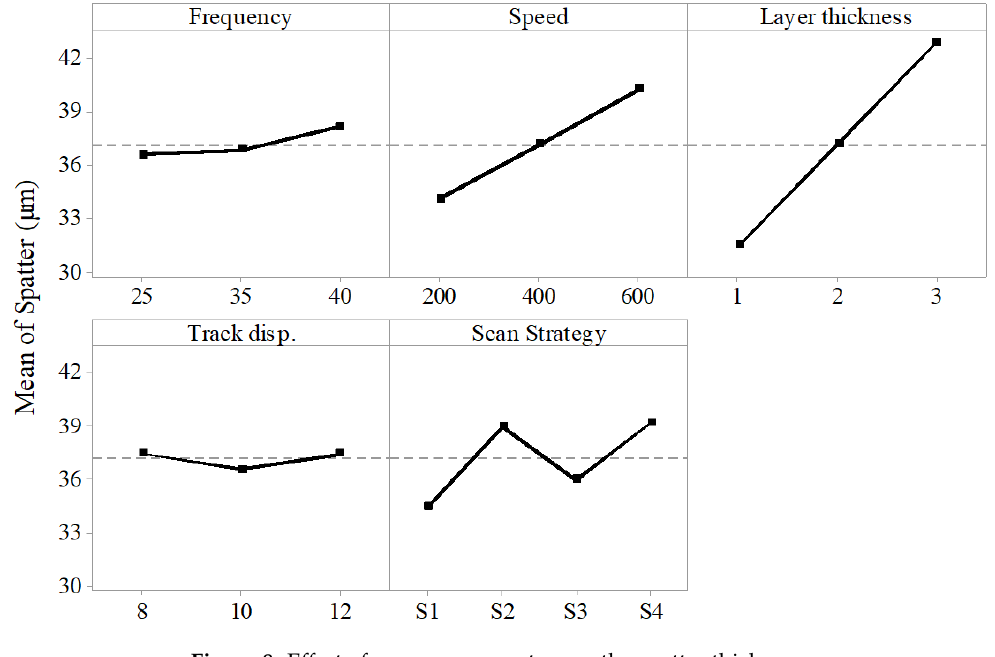
Figure 8. E ff ect of process parameters on the spatter thickness. Figure 8. Effect of process parameters on the spatter thickness. Figure 8. Effect of process parameters on the spatter thickness.